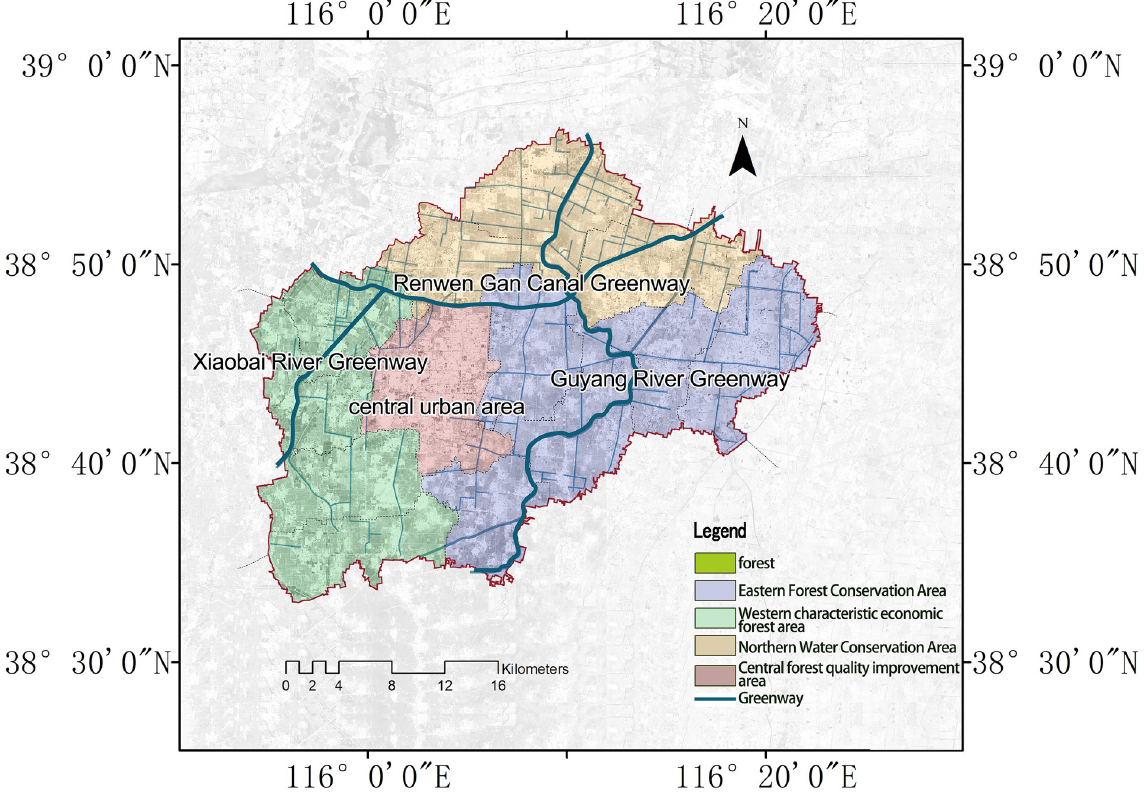
Fig 14. Diagram of spatial optimization strategy for forested landscape in Renqiu